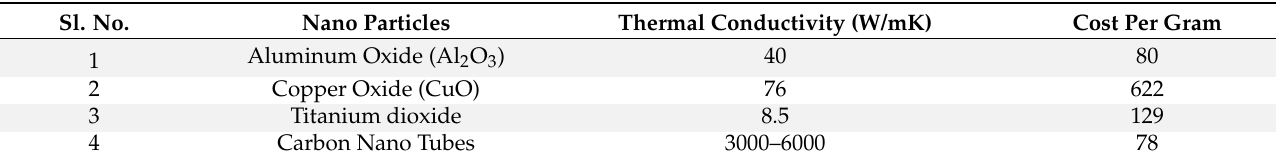
Table 6. Thermal conductivity and cost comparison of